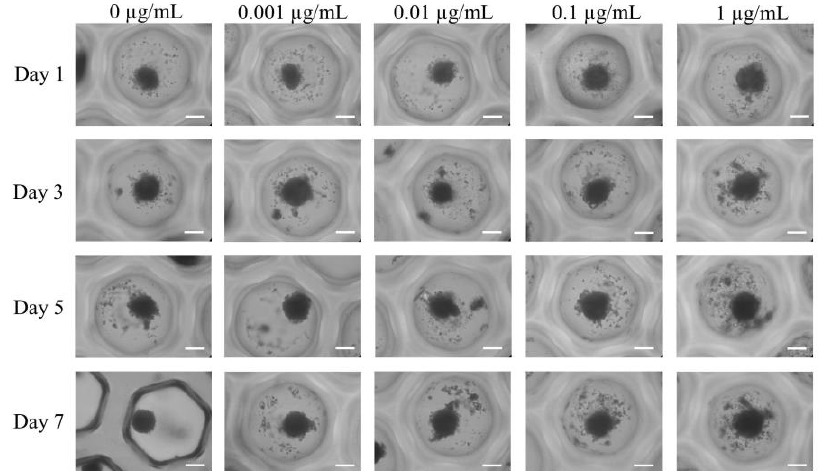
Figure 2. The morphology of the cell spheroids on Days 1, 3, 5, and 7 after exposure to various CMT concentrations in osteogenic medium was assessed using inverted microscopy (original magnification ×200). The bar shows 200 μ m.